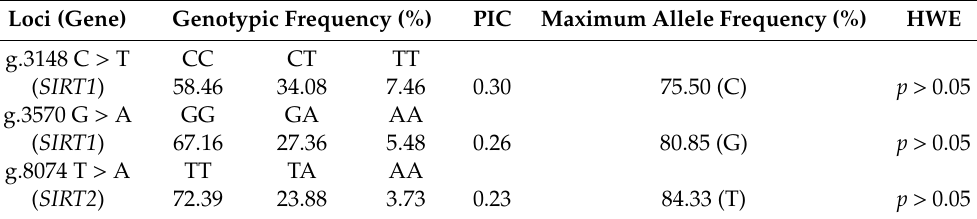
Table 2. Population genetic analysis of SNPs in SIRT1 and SIRT2 .